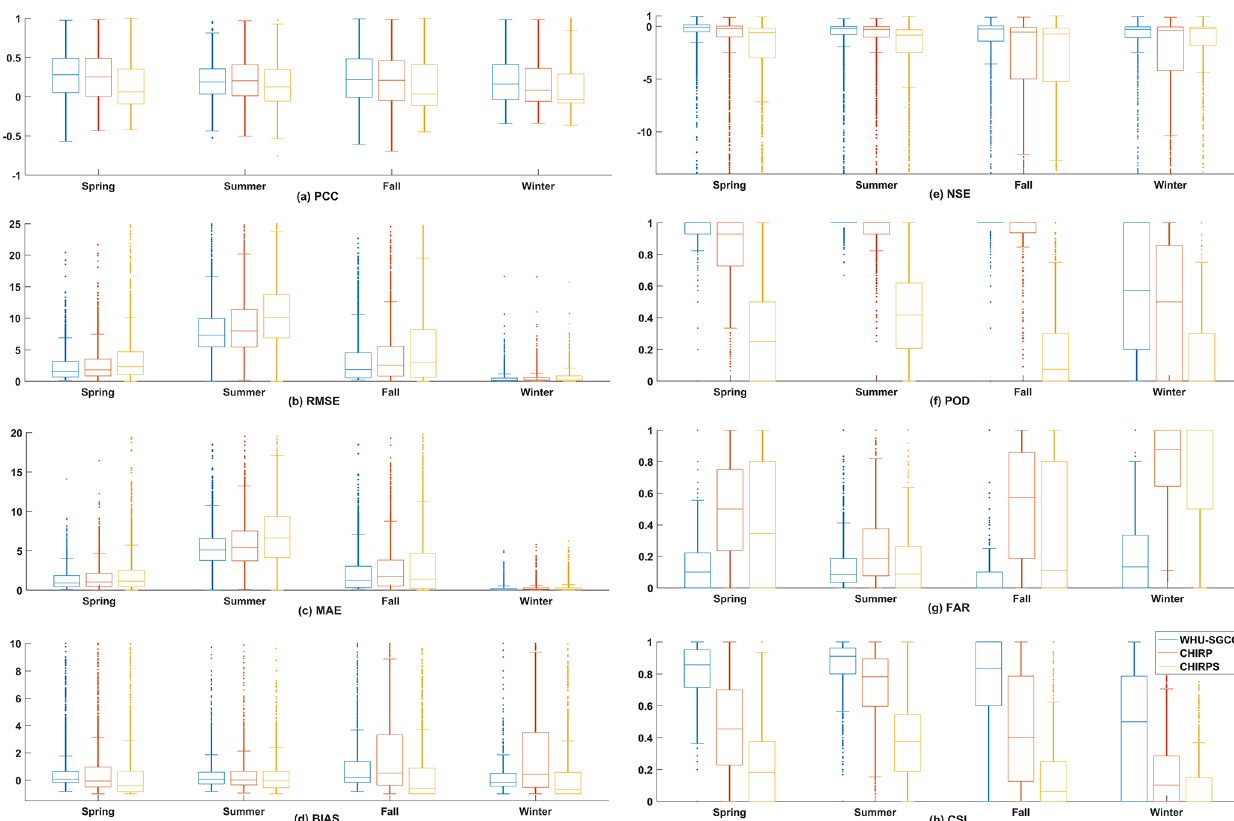
Figure 7. Statistical analysis of the agreement between the daily observations and the WHU-SGCC, CHIRP, and CHIRPS estimates with the leave-one-out cross validation: (a) Pearson’s correlation coefficient, (b) root mean square error, (c) mean absolute error, (d) relative bias, (e) Nash–Sutcliffe efficiency coefficient, (f) probability of detection, (g) false alarm ratio, and (h) critical success index. Table 5. The average percentage of each class of rain event at the validation gauge station during the four seasons from 1990 to 2014 within the Jinsha River basin. Rain event <0.1 [0.1,